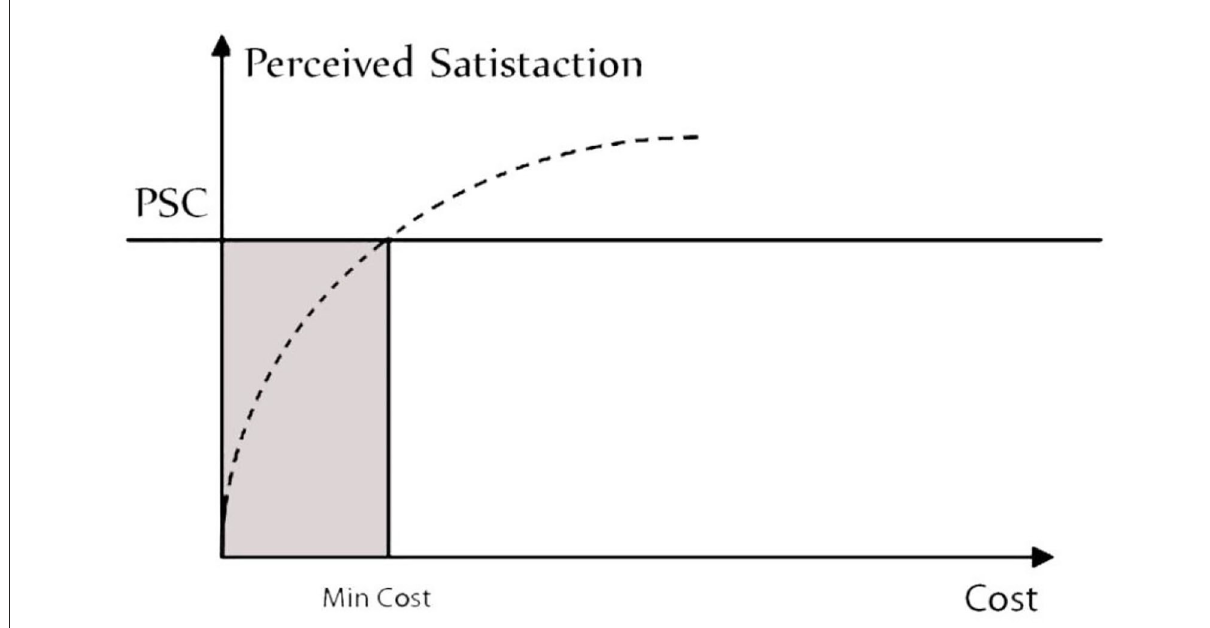
FIGURE6 Cost–benefit link between perceived pleasure and